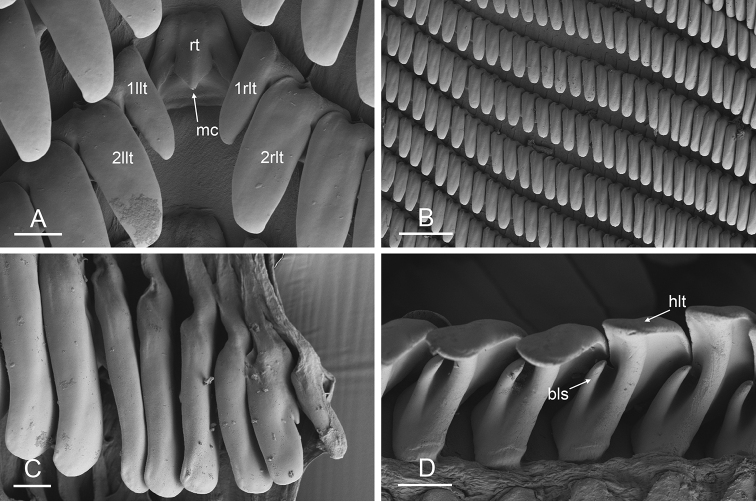
Radula, Peronia
verruculata (unit #1), Vanuatu [5481] (MNHN-IM-2013-62393) A rachidian and innermost lateral teeth B lateral teeth C outermost lateral teeth D lateral teeth, frontal view. Scale bars: 20 μm (A), 100 μm (B), 10 μm (C, D). Abbreviations: 1llt first left lateral tooth, 1rlt first right lateral tooth, 2llt second left lateral tooth, 2rlt second right lateral tooth, bls basal lateral spine, hlt hook of a lateral tooth, mc median cusp, rt rachidian tooth.